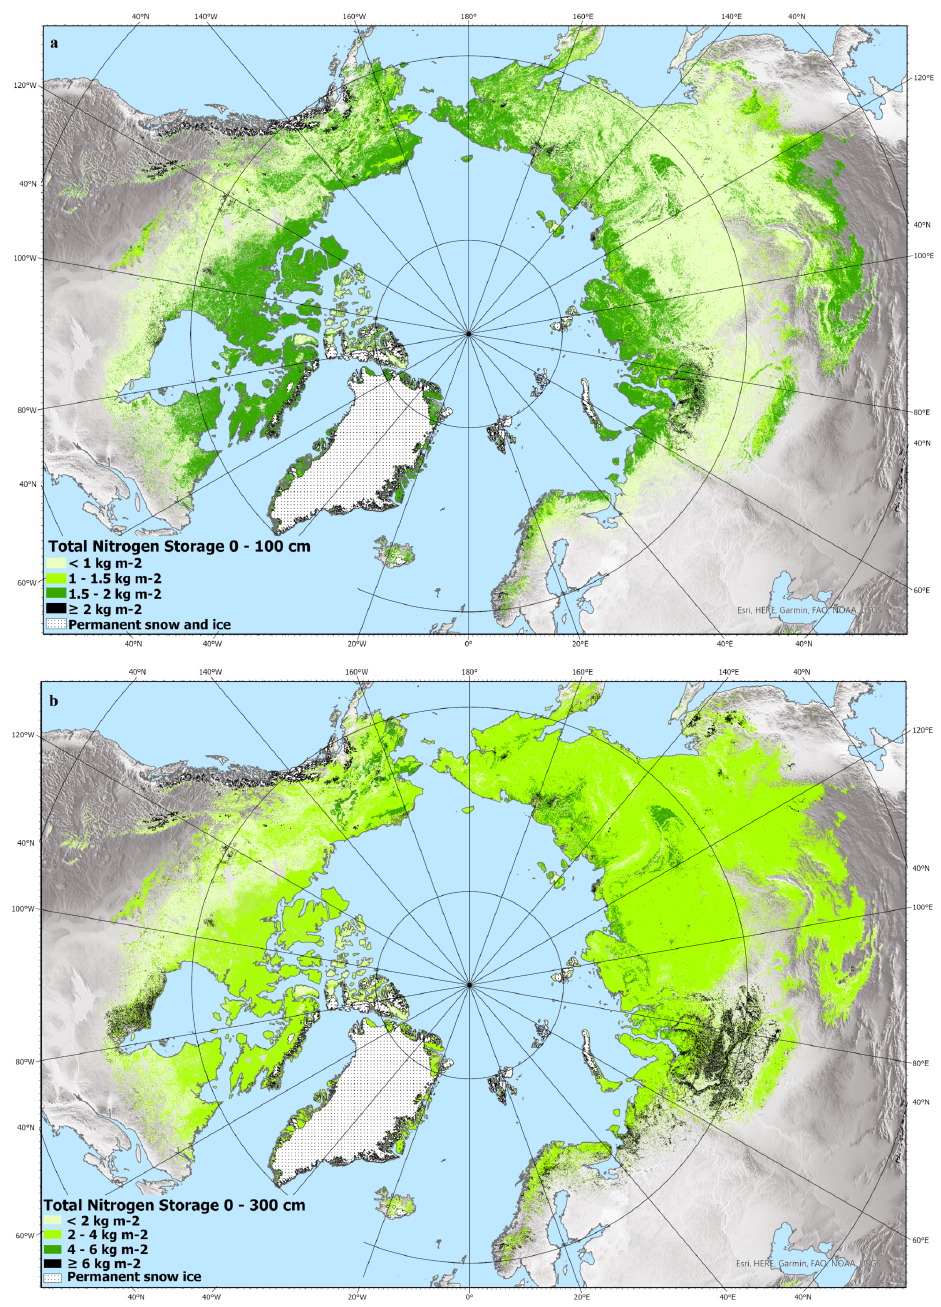
Figure 4. Estimated total nitrogen storage (kgNm − 2 ) to a depth of 0–100 and 0–300cm in northern circumpolar permafrost region. North Pole Lambert azimuthal equal area projection (datum: WGS 84). Base map: made with Natural Earth.